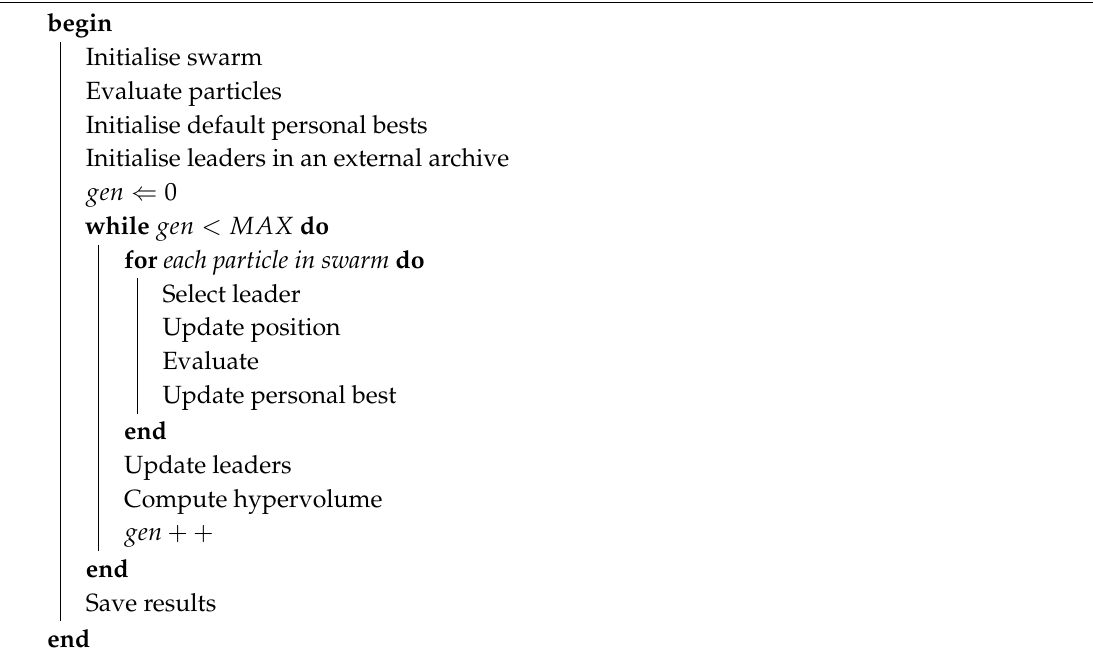
Algorithm 2: Multi-Objective PSO